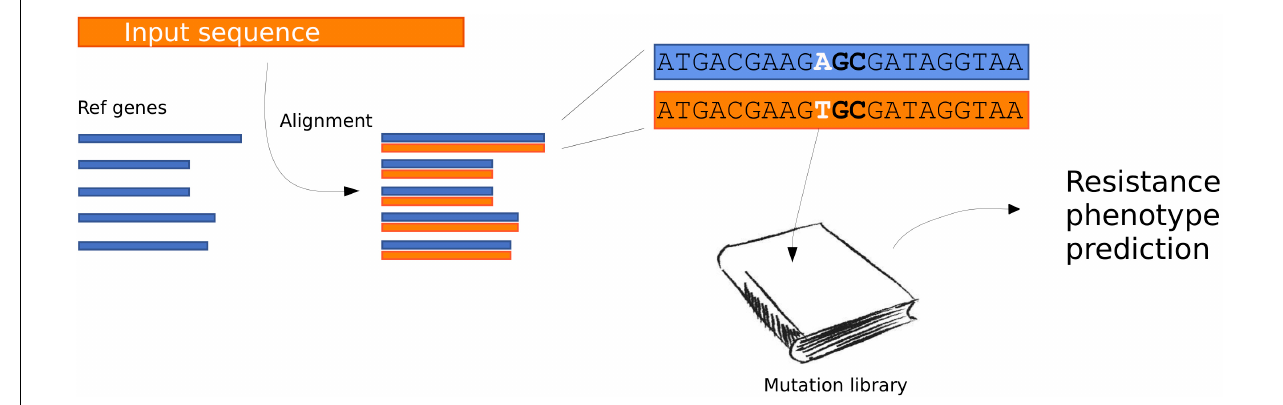
FIGURE 1 | Flow chart describing the PointFinder workflow. The input sequences are aligned to a database of reference genes. The genetic differences observed in the alignments are compared to a mutation library, with annotated phenotypes. Based on this a resistance phenotype prediction is